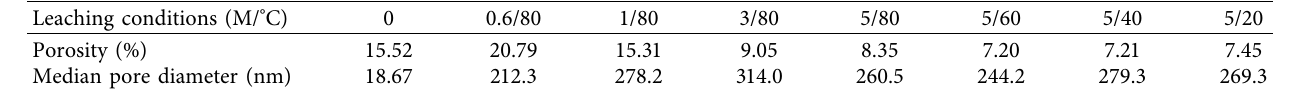
Figure 4: The distribution curves of pore diameter of fly ash/cement waste forms after leaching under simultaneous effect: (a) the NH concentration is from 0 to 5M while the temperature is 20 ° C; (b) the temperature is from 20 to 80 ° C while the NH 4 Cl concentration is 5M. Table 4: The characteristics of pore structure of fly ash/cement waste forms.